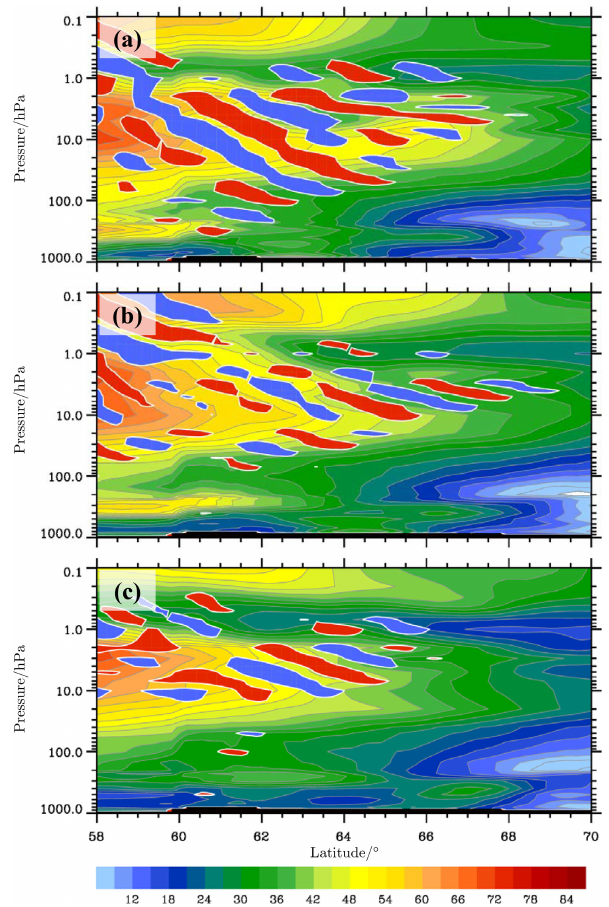
Figure 6. Composite of the magnitude of the balanced wind V BAL (ms − 1 , color shaded) and the unbalanced zonal wind U IGW (ar- eas with negative values larger than − 3ms − 1 and positive values smaller than 3ms − 1 are filled with blue and red, respectively) from the normal-mode analysis. The vertical sections are along the base- line sketched in Figs. 4 and 5 and they are valid on 30 January 2016 at 00:00UTC (a) , 06:00UTC (b) , and 12:00UTC (c)